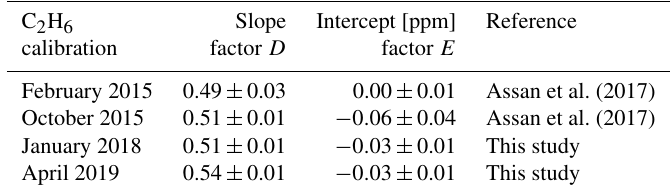
Figure 3. H 2 O influence on corrected C 2 H 6 . Water vapor is increased in small steps for 4h while measuring Target Gas 1. The three panels show the result of applying different water correction protocols for the next steps: (a) no correction, (b) high-humidity interference correction, (c) low-humidity interference correction. In all cases, for H 2 O = 0.00%, C 2 H 6 is corrected using low-humidity interference correction. The red line represents 0ppb. Table 3. Summary of the calibration factors for the CRDS G2201-i device CFIDS